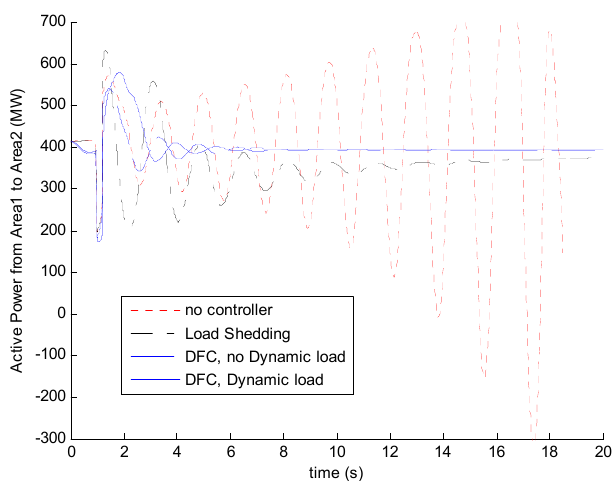
Figure 6. The tie-line active power (MW) from area1 to area2 when a three-phase short-circuit fault occurs (i) no DFC; (ii) load shedding control; (iii) DFC without dynamic loads; (iv) DFC considering dynamic loads.